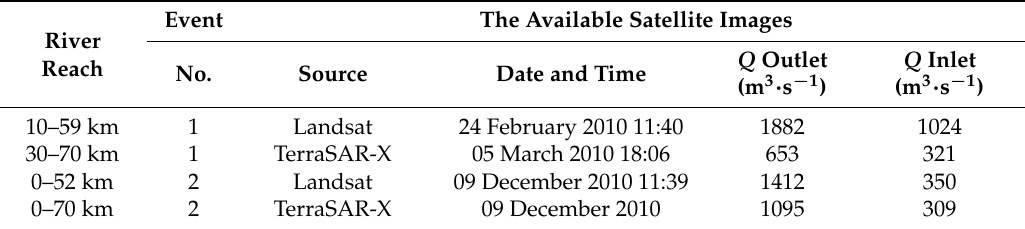
Table 2. The Landsat and TerraSAR-X imageries used in this